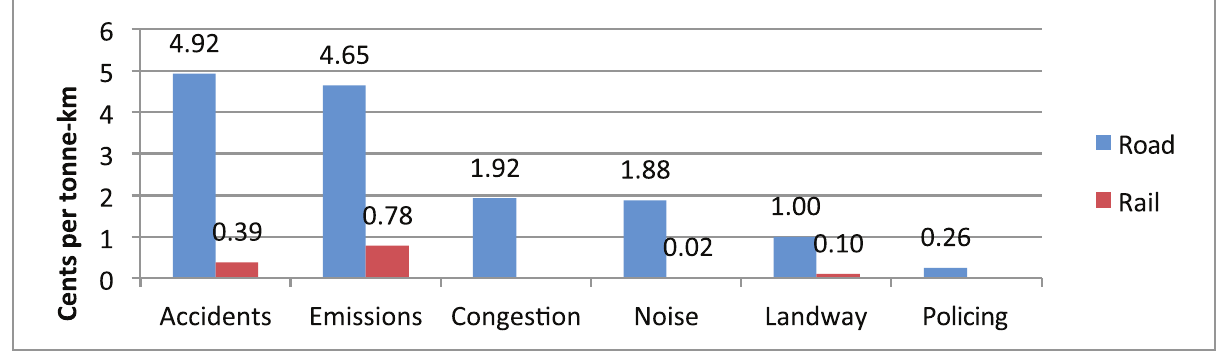
Figure 1: South Africa’s surface freight transport externality costs based